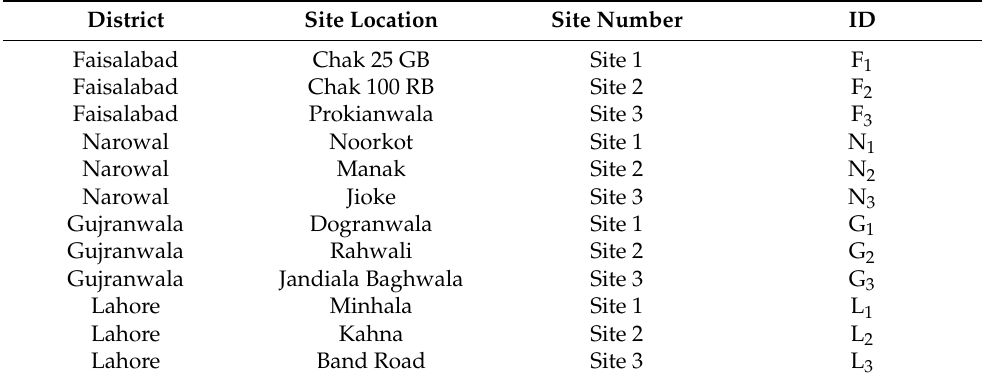
Table 1. Site distribution of study area of various districts of Punjab, Pakistan.